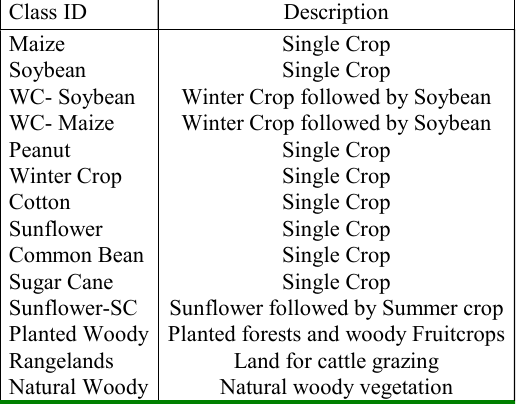
Table 1. Classes defined for mapping